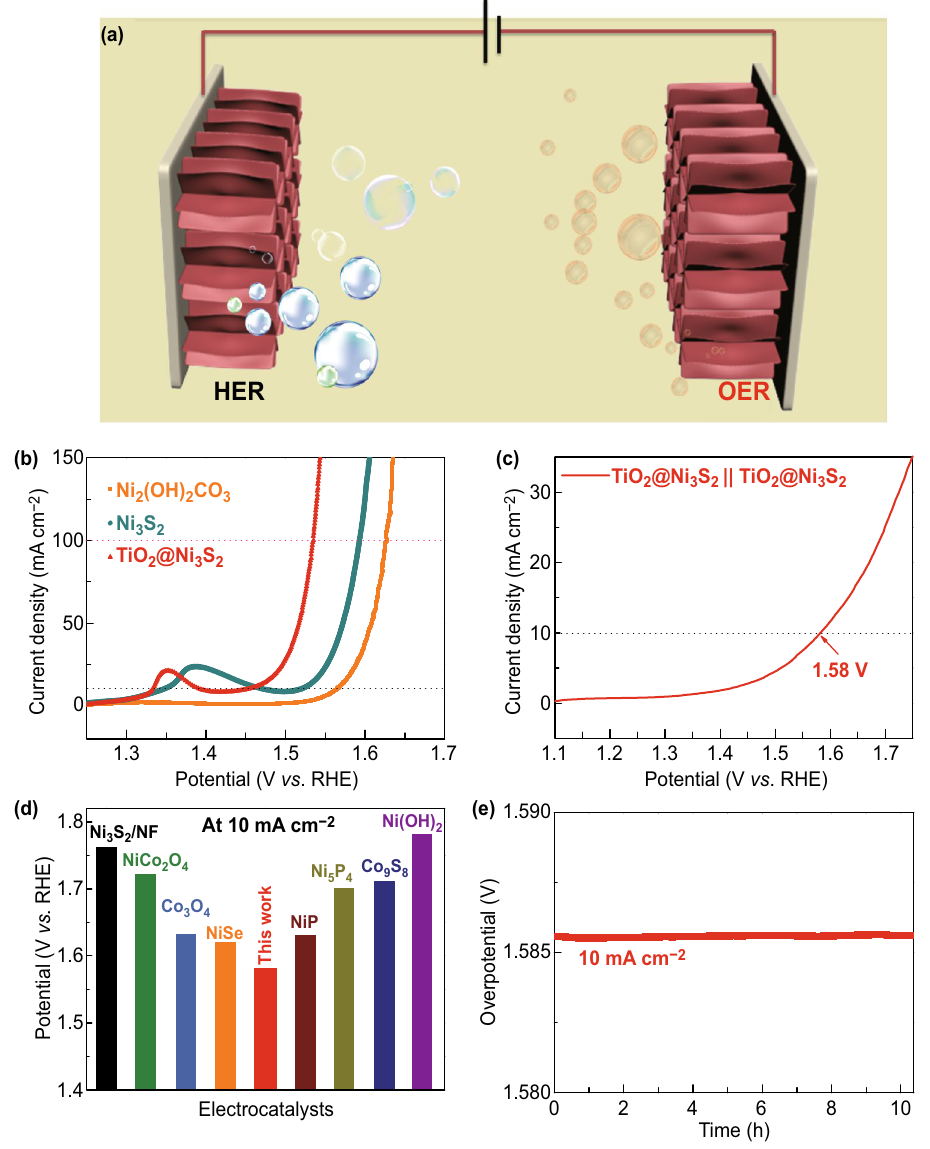
Fig. 5 a Schematic illustration of the overall water-splitting process using the bifunctional electrocatalyst. b LSV curves at 5 mV s −1 for the OER performances using the Ni 2 (OH) 2 CO 3 , Ni 3 S 2 , and TiO 2 @Ni 3 S 2 electrodes. c LSV curves of the overall water-splitting performance of the TiO 2 @Ni 3 S 2 ||TiO 2 @Ni 3 S 2 electrolyzer. d Comparison of the overall water-splitting performance of our TiO 2 @Ni 3 S 2 ||TiO 2 @Ni 3 S 2 electrolyzer with those of other electrocatalysts in the literature, and e electrochemical stability at 10 mA cm